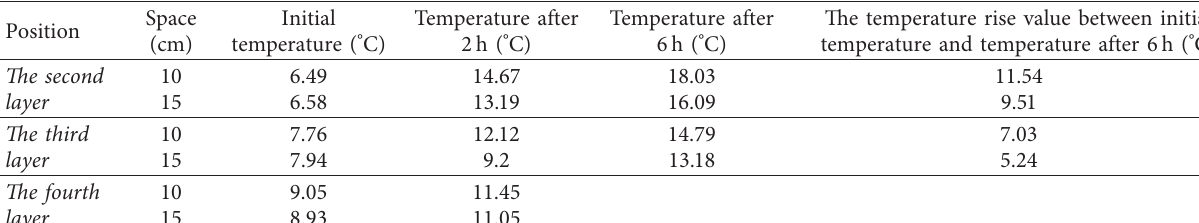
Table 10: Temperature rise value of the second, thirds and fourth layers under two different space conditions. Position